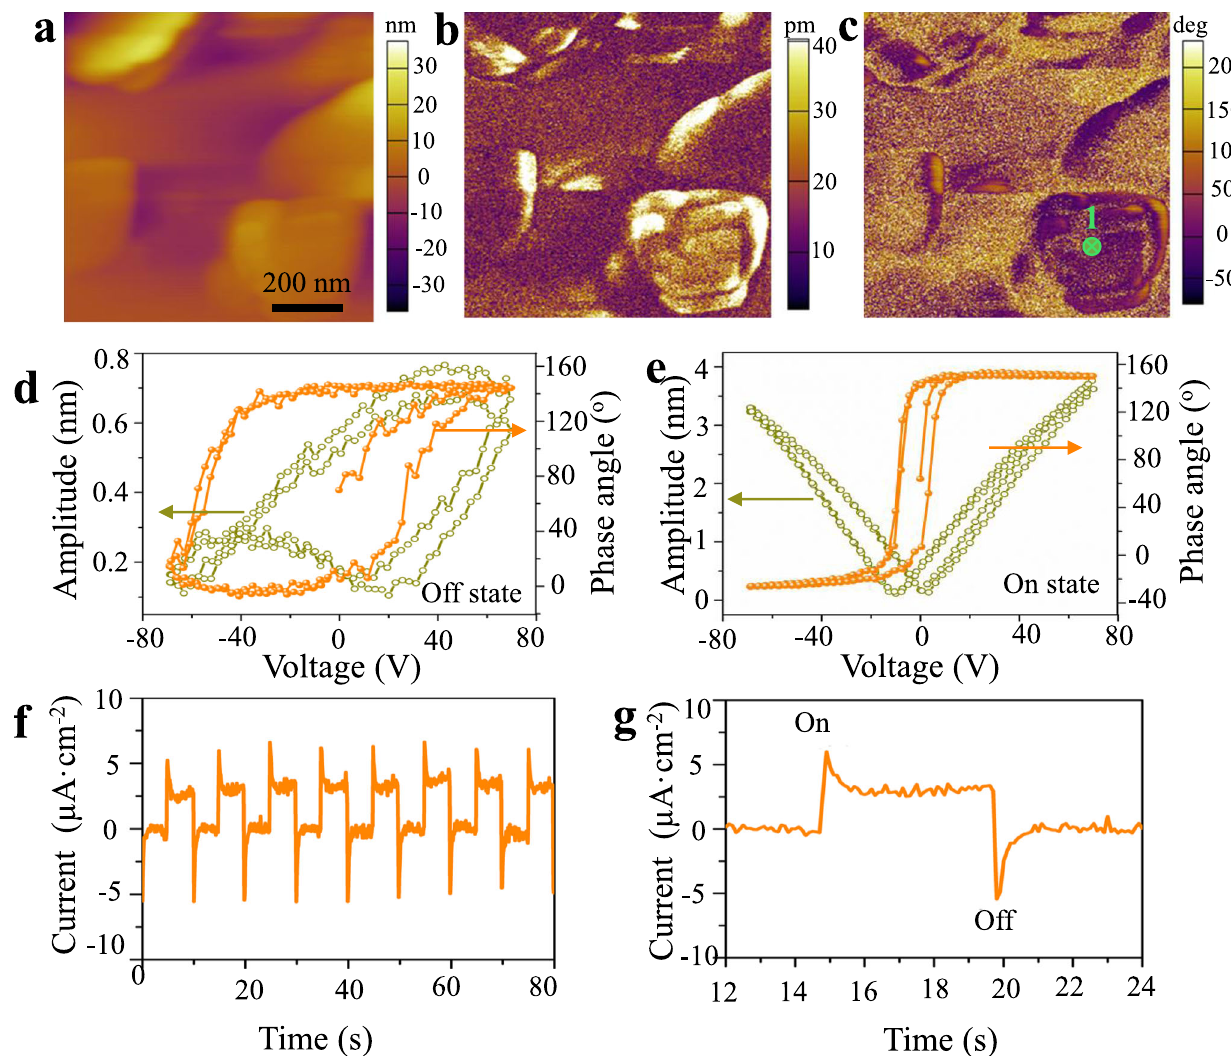
Fig. 2 Ferro-/pyroelectric properties of Bi 2 WO 6 . a Topology, b vertical amplitude, and c phase images of Bi 2 WO 6 nanoplate. The local hysteresis loops of Bi 2 WO 6 nanoplate for point 1 marked in c : d “ off ” state, and e “ on ” state. f The Pyro-current response of Bi 2 WO 6 , g enlarged view of one full light on/off cycle is shown in f